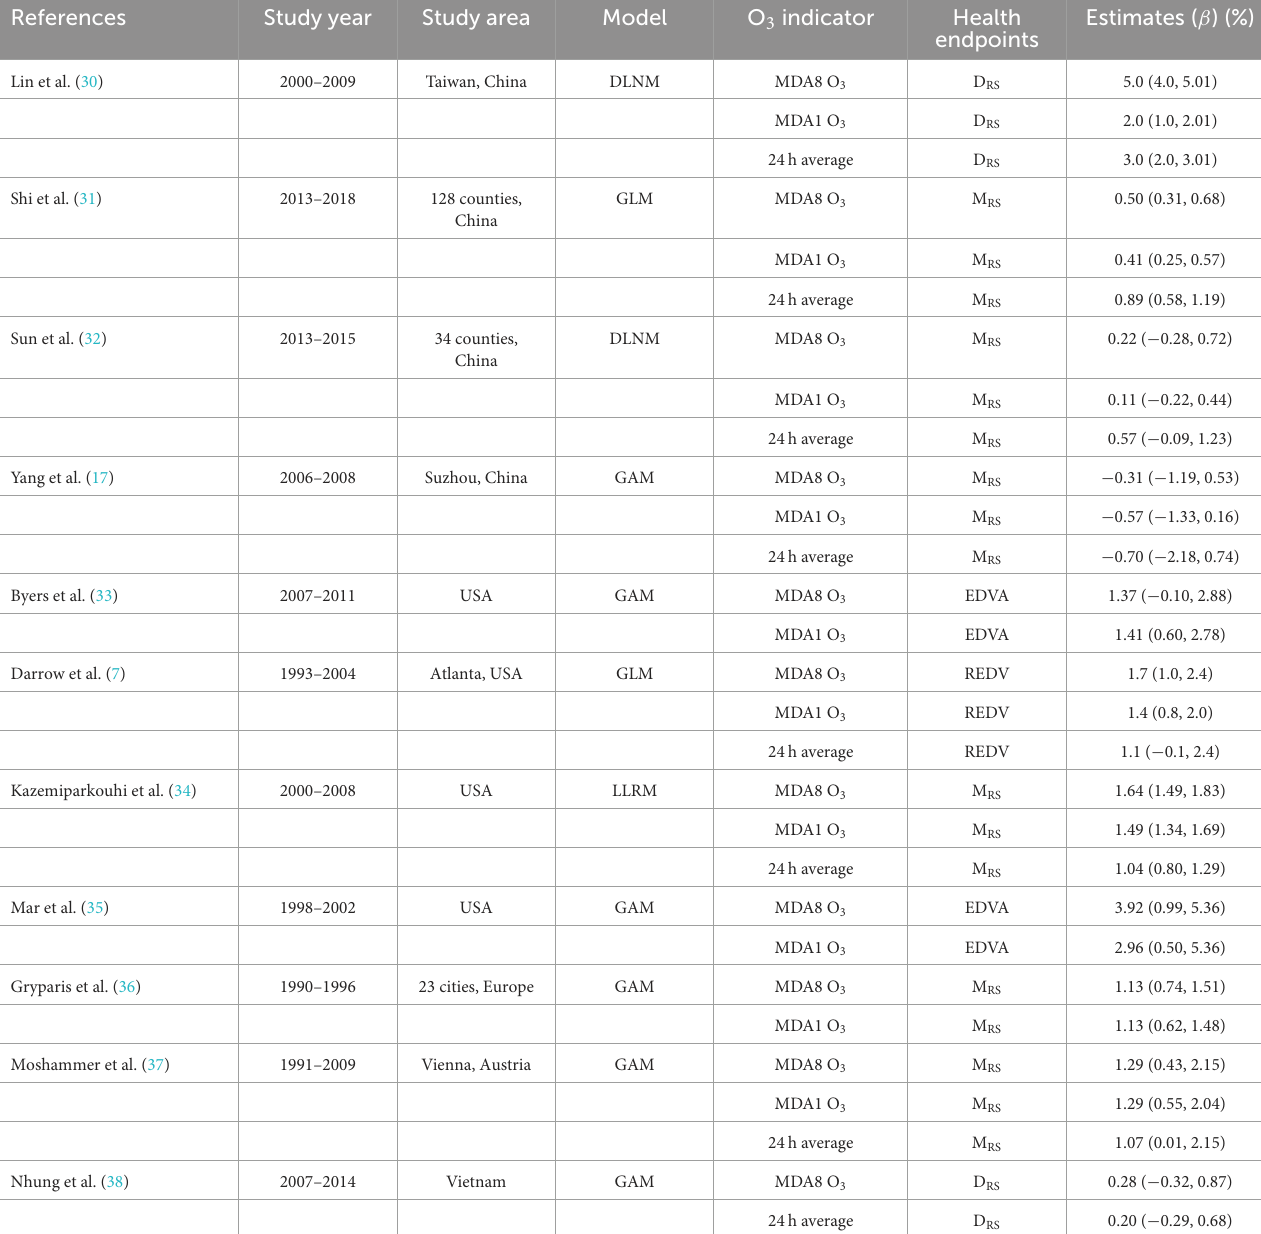
TABLE 2 Various studies on respiratory mortality attributed to different O 3 indicators after the year 2000